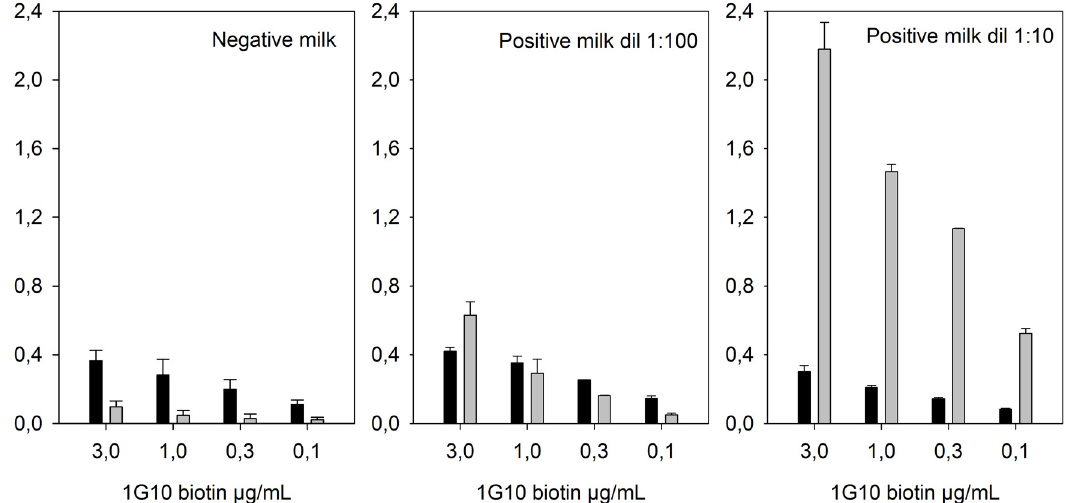
Fig 2. Optimization of detector mAb (1G10-biotin) concentration. Net OD (grey columns), and OD Ag - (black columns) registered in the analysis of negative diluting milk and an individual positive milk sample diluted 1:10 and 1:100 in negative diluting milk, as obtained with the ANANAS-integrated test using biotin-1G10 at different concentrations. TMB development was blocked after 10 min reaction. Each sample was analyzed in duplicate. These data are also reported in table format in (S1 Table).